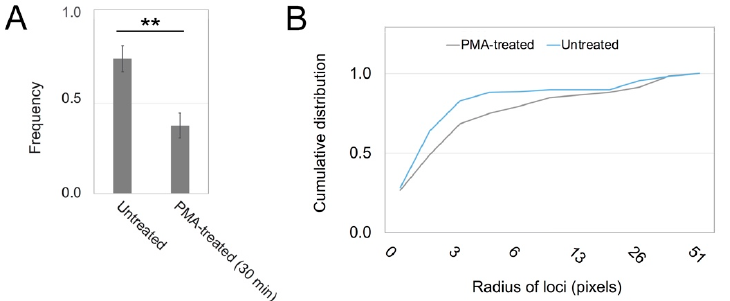
Figure 5. Treatment with PMA inhibits GG-form conversions and enhances nanoparticle clustering in the ECR. ( A ) Representative results from three experiments showing the frequency with which RR-labeled sites coincide with GG labels. ( B ) Cumulative size distribution of Cy3-labeled objects in cells with and without PMA treatment for 15 min. Elevated frequencies in the low size range from the thresholded images indicate that the loci containing gold nanoparticles are slightly smaller. **means differ by p < 0.02